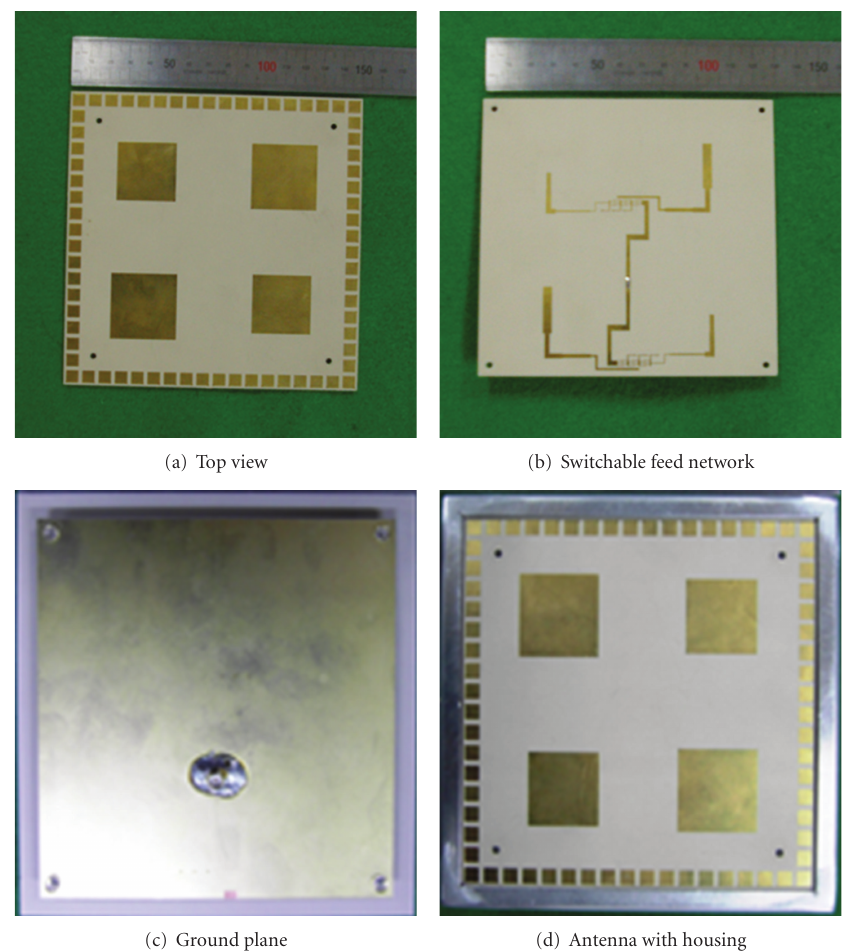
Figure 9: Photographs of the fabricated two-by-two microstrip patch array antenna.